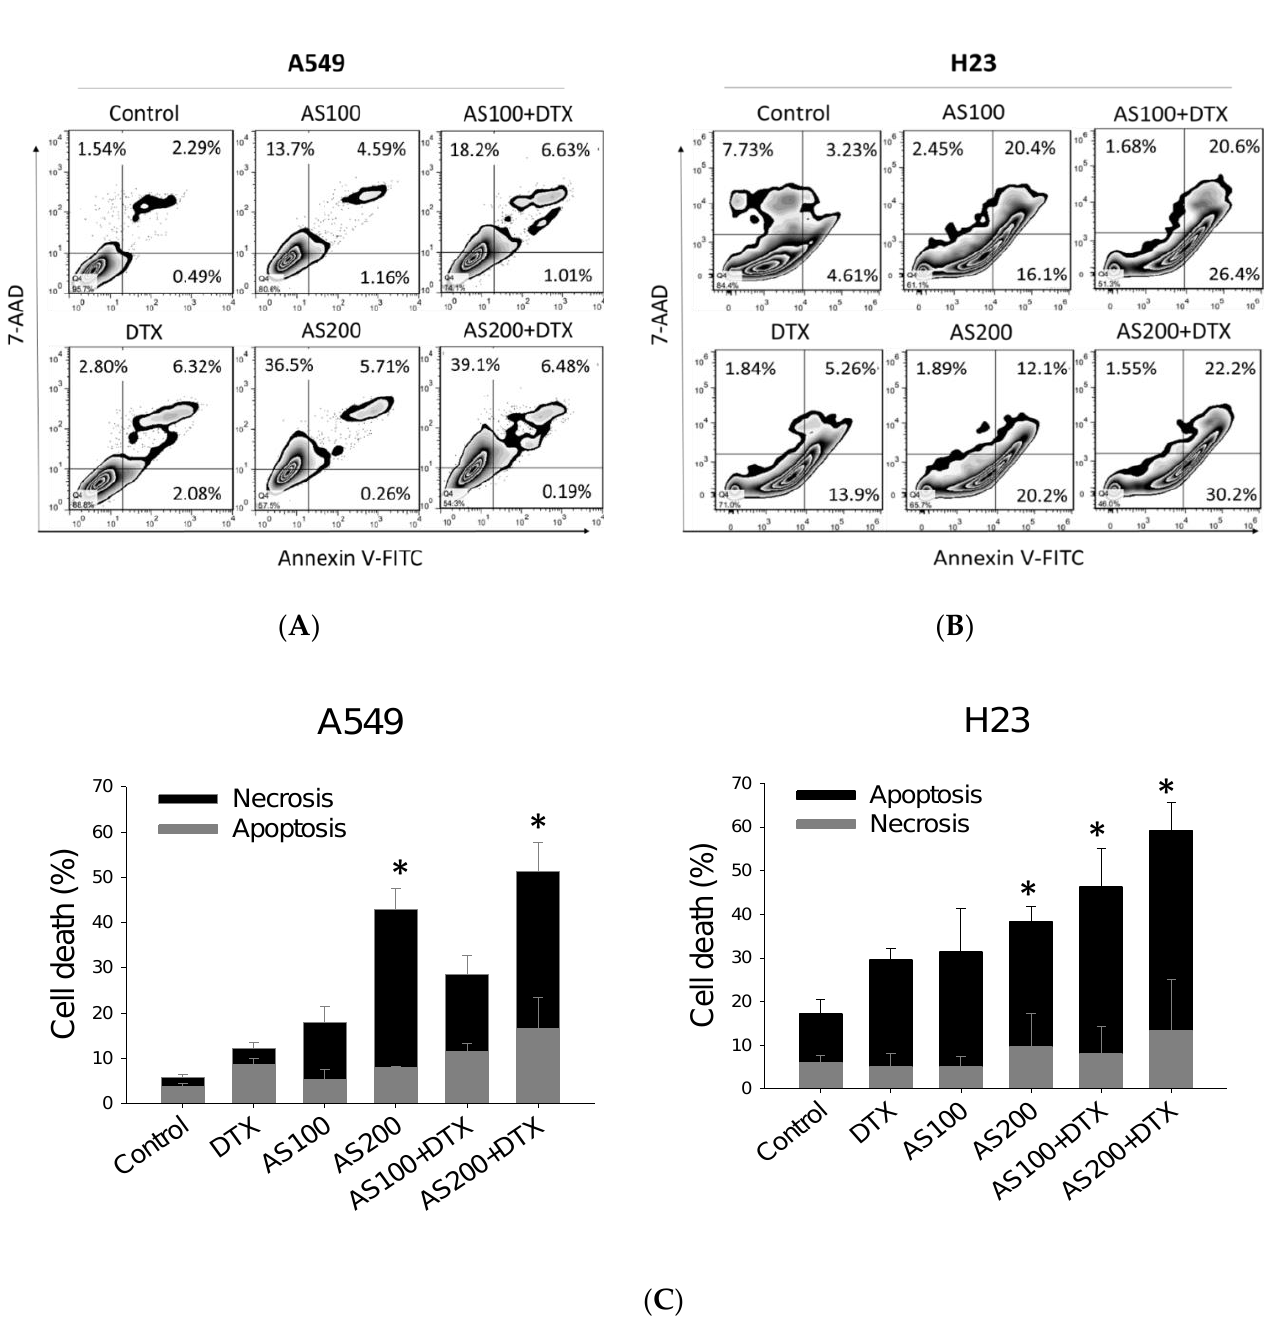
Figure 2. AS enhances DTX-induced apoptosis in NSCLC cells inducing different features of cell death. Analysis of cell death in NSCLC cells following AS and/or DTX treatment was performed through FCM with Annexin V/7-AAD staining. A549( A ) and H23 ( B ) cells were treated with 100 and 200 µg/mL AS and 0.5 nM DTX alone or in combination for 48 h. ( C ) The representative histograms and quantified results of three independent experiments are shown. Data are the mean ± SE; * p < 0.05 vs. corresponding control.